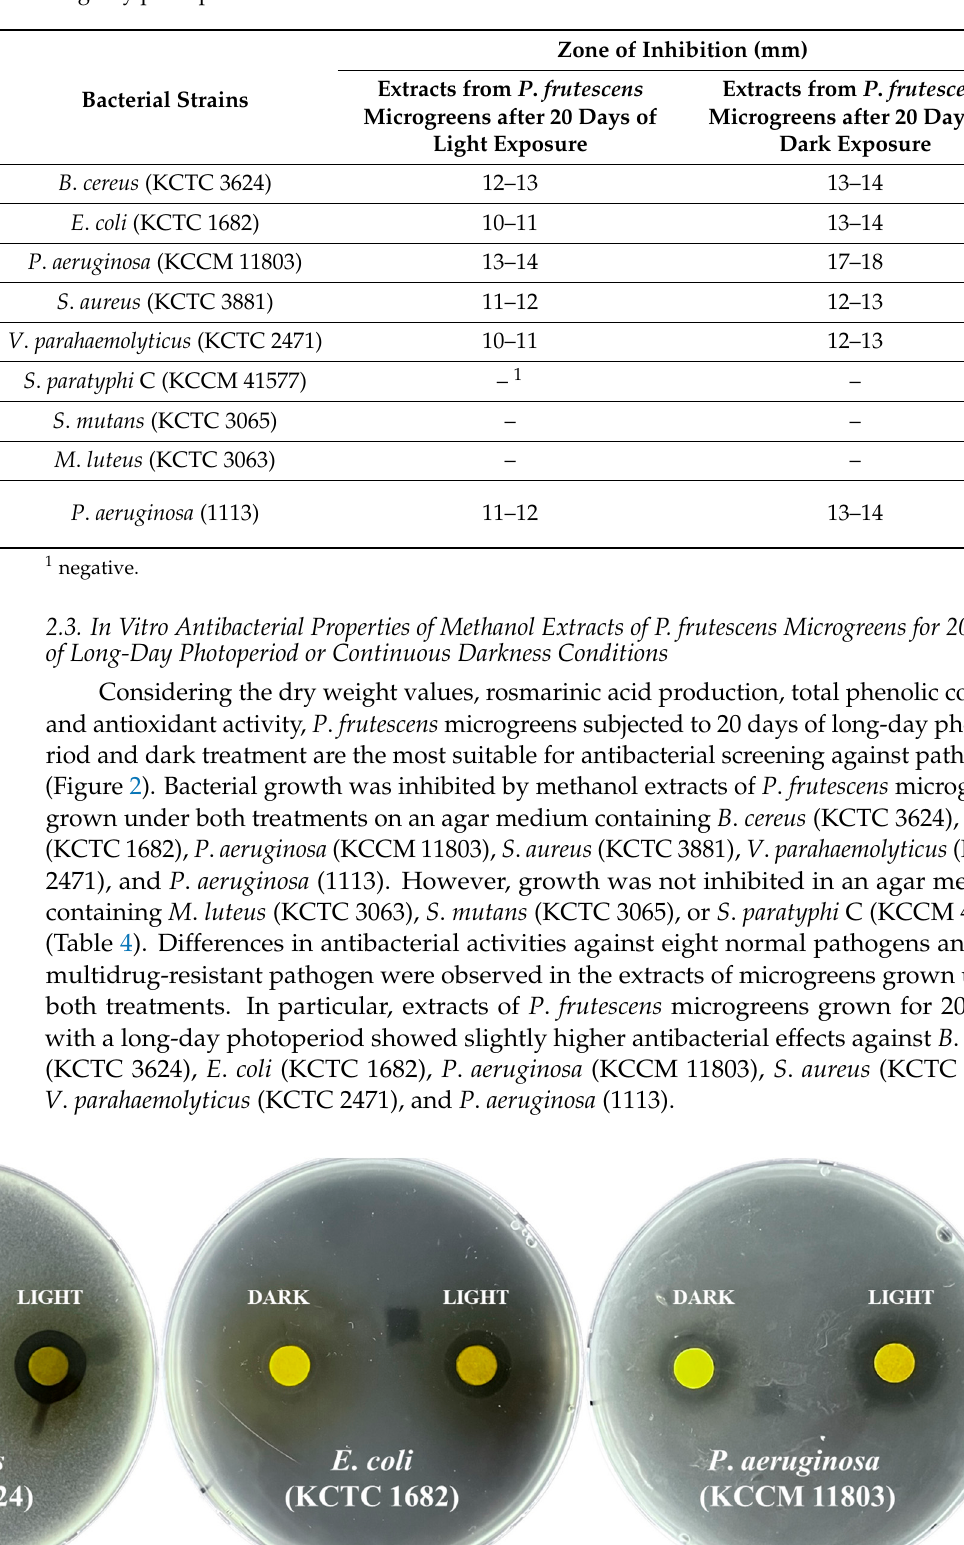
Table 4. Antibacterial activities of methanol extracts of P . frutescens microgreens for 20 days of long-day photoperiod and continuous darkness conditions.